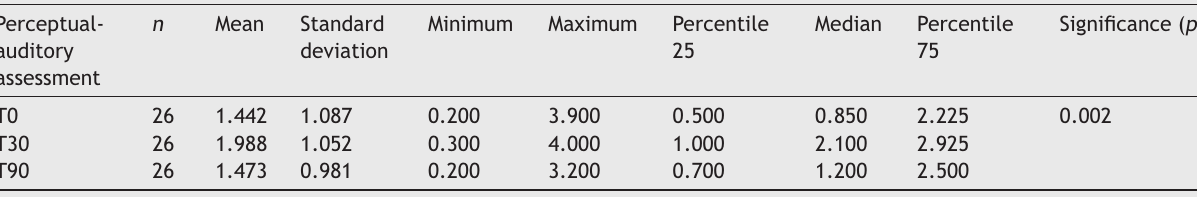
Perceptual-auditory assessment (VAS).